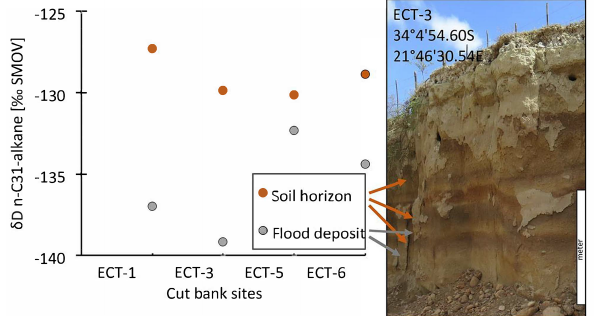
(d)(c)(b)(a) Figure 5. Variations in δ D of the n -C 31 -alkane (‰ VSMOW) in the distinct horizons of paleoflood vs. soil formation horizons. Gouritz River tributary cut bank at sample location ECT-3 is depicted as an example illustrating these alternating (e)